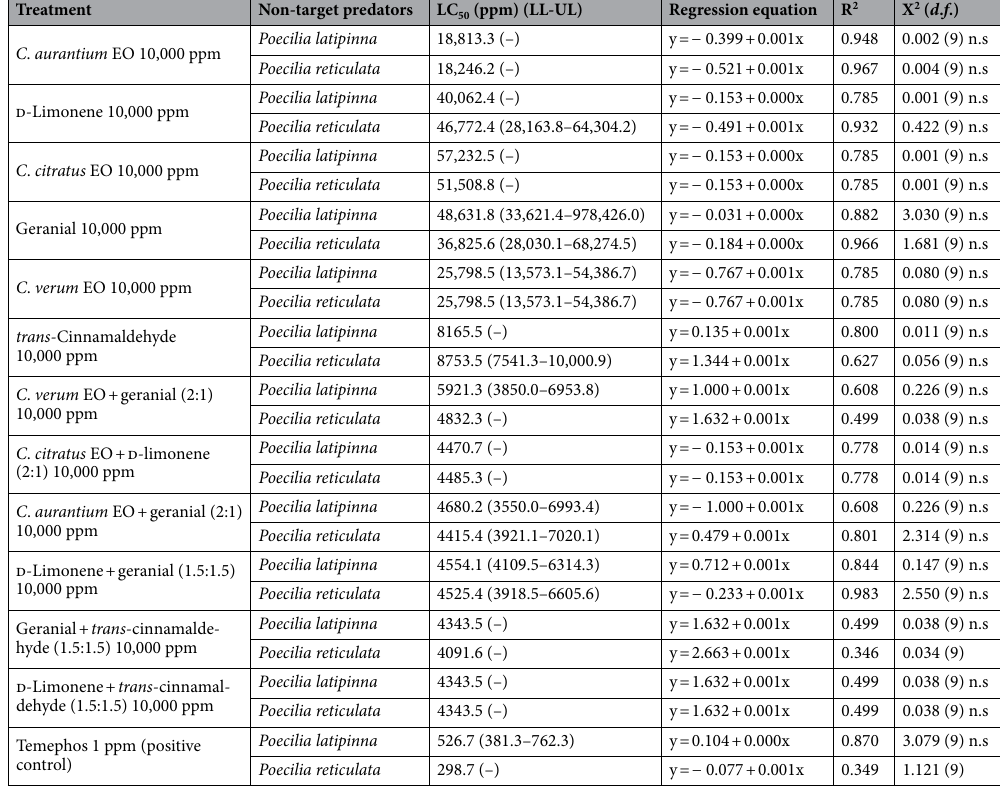
Table 4. Effect of Cinnamomum verum , Citrus aurantium , and Cymbopogon citratus EOs and their major constituents and combined formulations against Poecilia latipinna and Poecilia reticulate fishes sharing the same ecological niche of Aedes aegypti and Aedes albopictus . No mortality was observed in the control. LC 50 Lethal concentration that kills 50% of the exposed organisms, LL 95% lower confidence limit, UL 95% upper confidence limit, R 2 regression coefficient, d . f . degrees of freedom, n.s. not significantly different at P < 0.05, n/a not